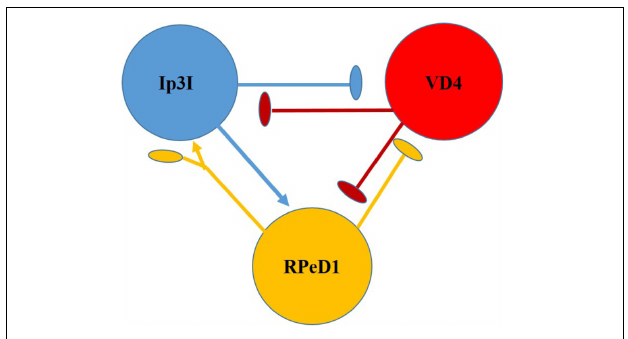
FIGURE 7 | Diagram of the neurons making up the respiratory CPG of Lymnaea stagnalis. RPeD1 initiates the RCPG rhythm, VD4 drives inspiration and pneumostome closure, while the input 3 interneuron (Ip3I) drives expiration and pneumostome opening. Ovals are inhibitory synapses and arrows are excitatory synapses. RPeD1 has a biphasic synaptic connection to Ip3I (For further detail, see Syed et al.,